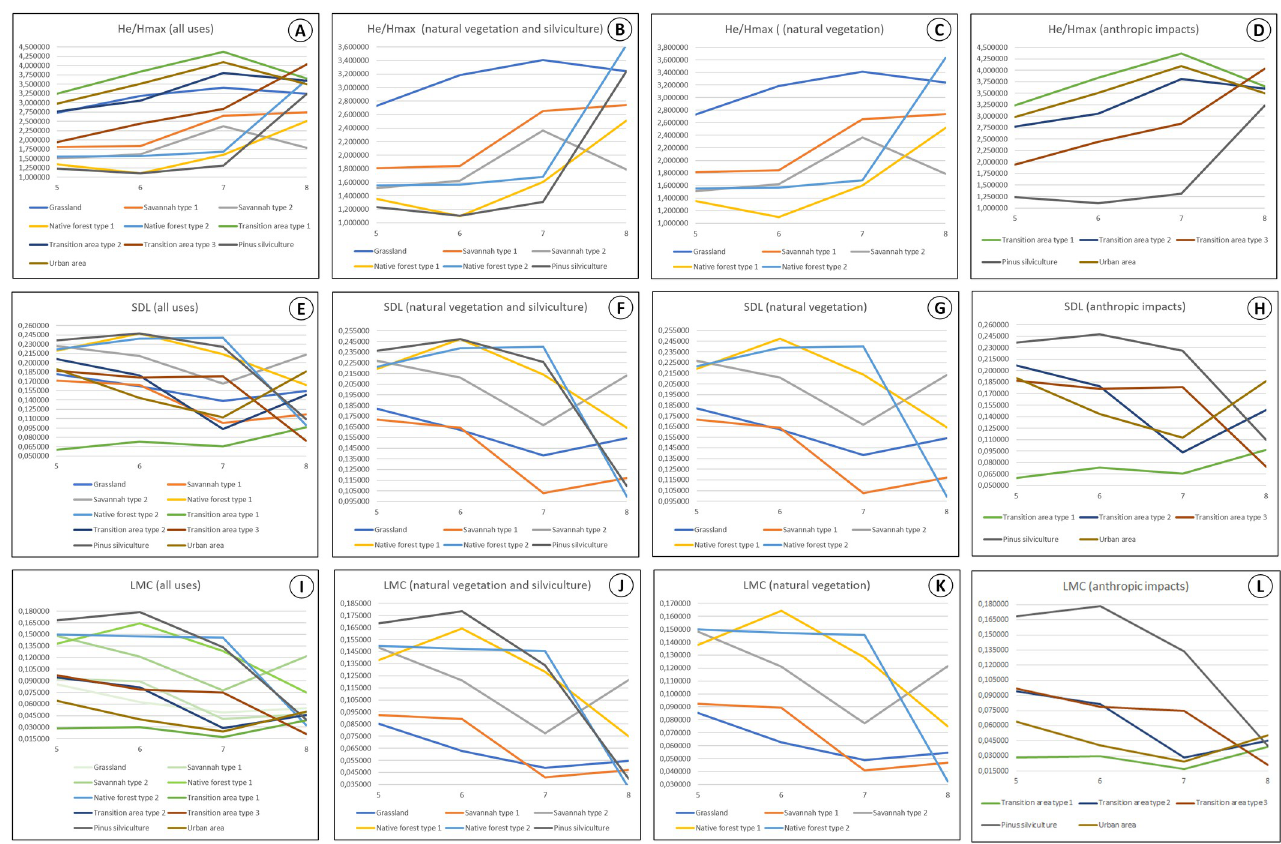
Fig 8. Complexity signatures for variability, SDL, and LMC measures of different landscape uses from the Itirapina Ecological and Experimental Parks and their surroundings (State of Sao Paulo,